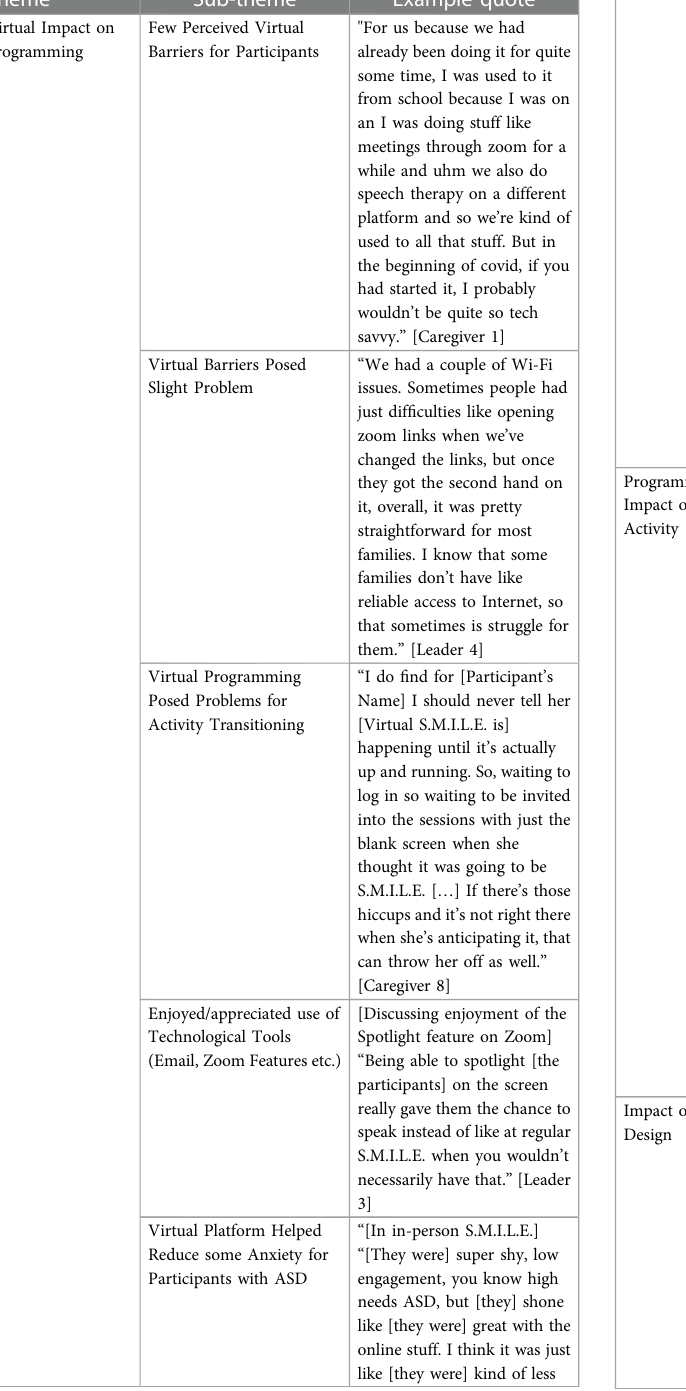
TABLE 5 Themes and subthemes from the caregiver and leader